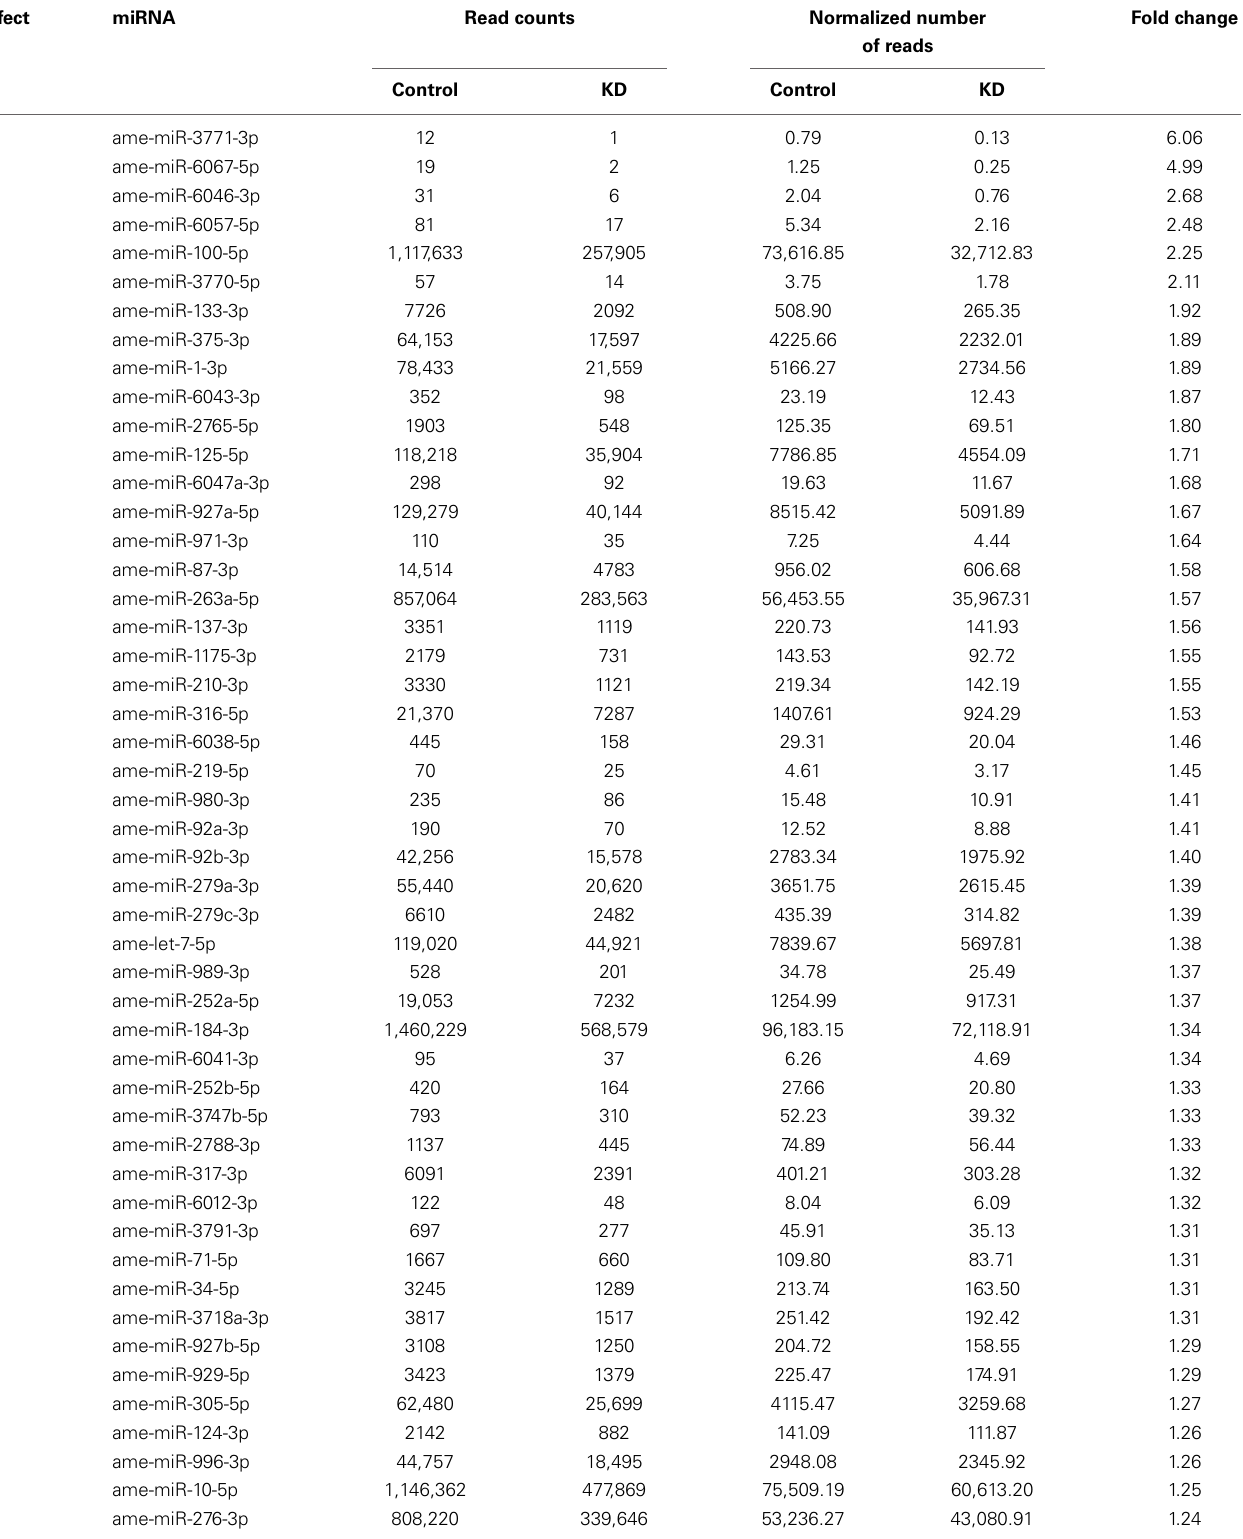
Table 3 | miRNAs that were differentially expressed in EcR-knockdown bees.